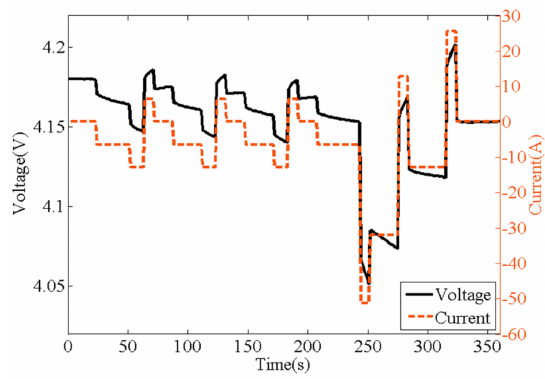
Figure 6. ( a ) The experimental curve of voltage and current of 1 / 3C discharge and 3 h rest in a cycle under Hybrid Pulse Power Characterization (HPPC) test. ( b ) The experimental curve of voltage and current of 1C pulse discharge and charge in a cycle under HPPC test.